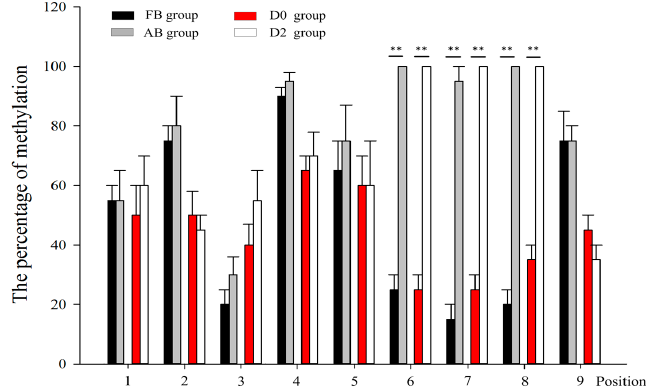
Figure 3. Methylation levels of the SIX1 gene core region containing 9 CpG sites were analyzed using a bisulfite sequencing protocol in the FB, AB, D0, and D2 groups. The results are expressed as the means ± SD. “**” p < 0.01.